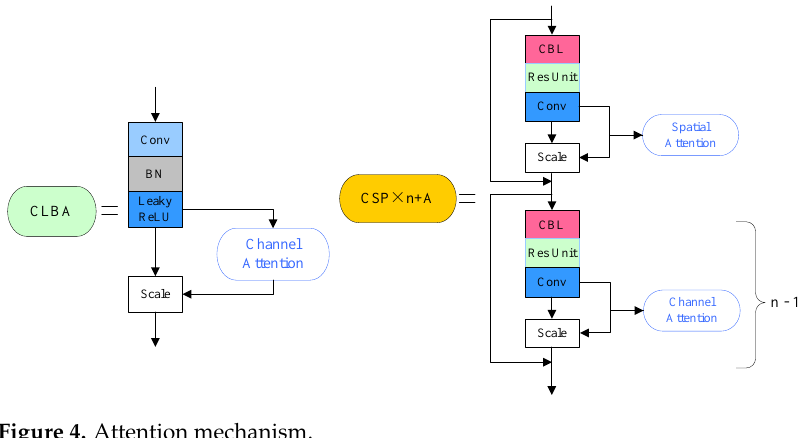
Figure 4. Attention